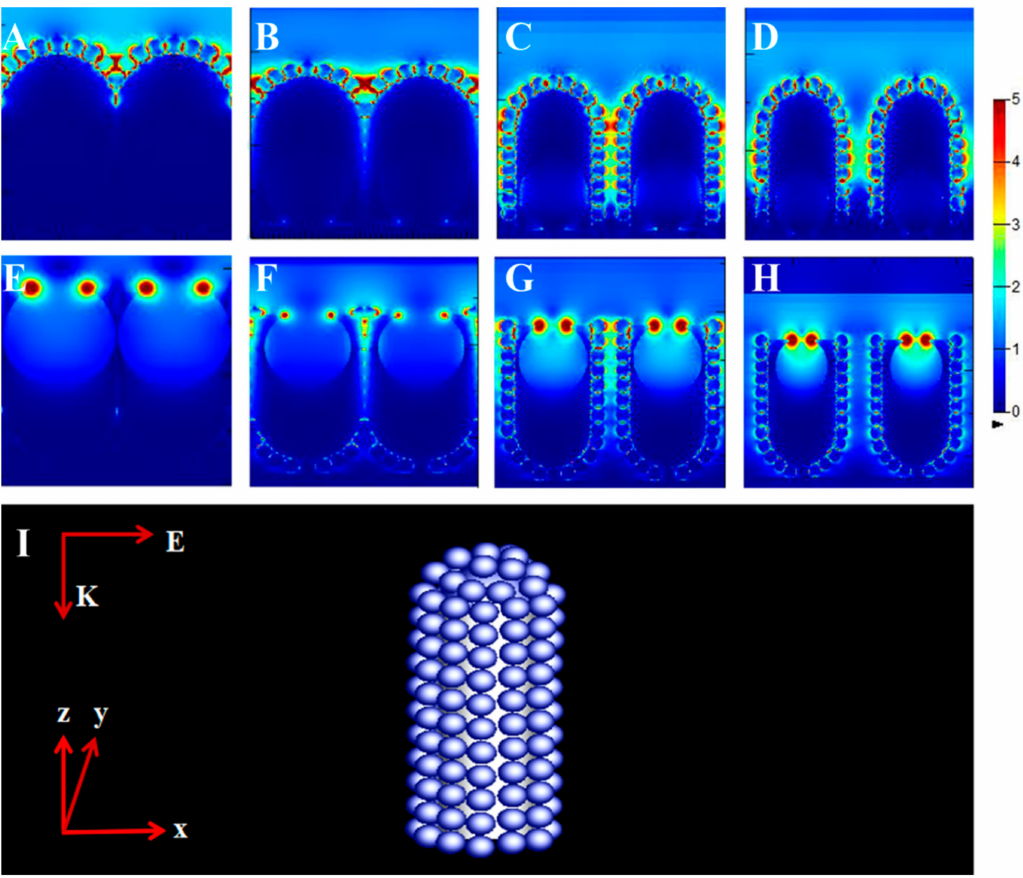
Figure 5. The finite-difference time-domain (FDTD) simulation of the tops and bottoms of nanomace arrays, with PS spheres etched for ( A , E ) 0 s; ( B , F ) 60 s; ( C , G ) 90 s; ( D , H ) 120 s. ( I ) The FDTD model of Ag–SiO 2 nanomace